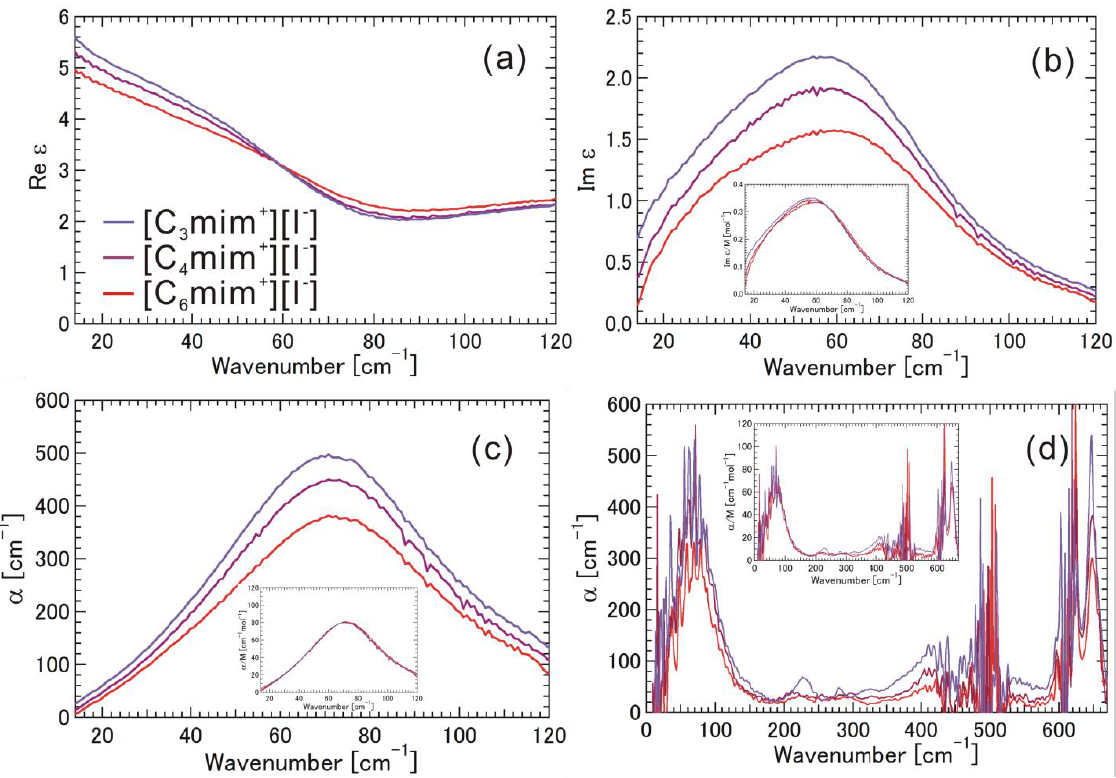
Figure 2. ( a ) Real part of the complex dielectric spectra (Re ε); ( b ) Imaginary part of the complex dielectric spectra (Im ε); ( c ) Absorption coefficients (α) obtained by THz time-domain spectroscopy (THz-TDS); and ( d ) Absorption coefficients (α) obtained by far-infrared (FIR) for the ionic liquids [C 6 mim + ][I − ], [C 4 mim + ][I − ], and [C 3 mim + ][I − ]. The imaginary part of the complex dielectric spectra (Im ε/M) and the absorption coefficient (α/M) normalized by molar concentration are also shown in the